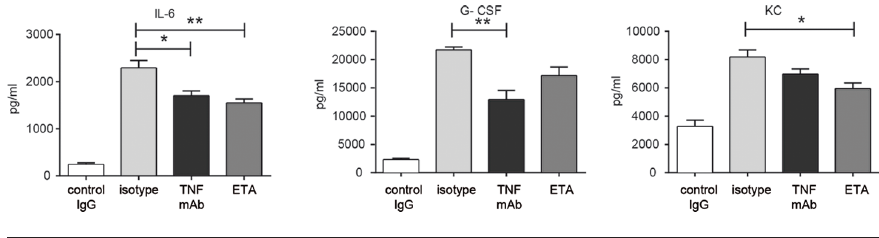
Figure 4. TNF inhibition in antibody transfer–induced EBA was associated with changes in